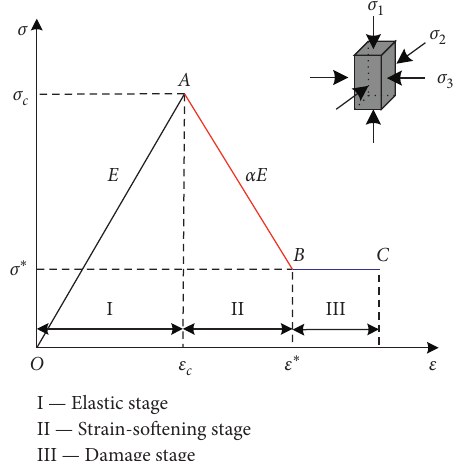
Figure 2: Simplified strain-softening model of the rock